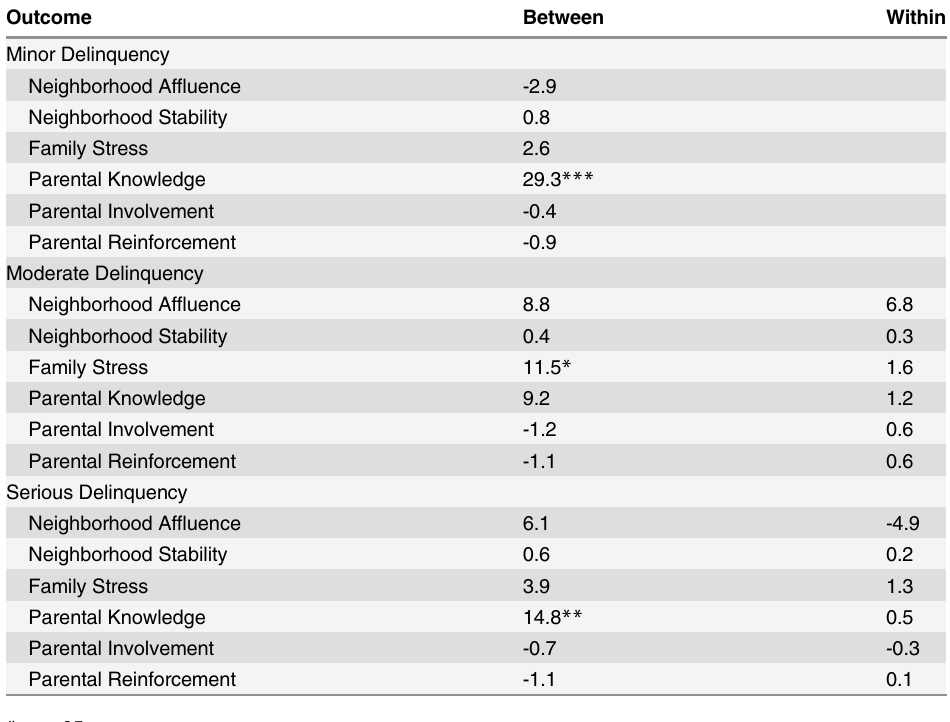
Table 7. Percentage of SES Effect Accounted for by Mediator. Note . Significance tested using Sobel test [50]. Outcome Between Within Minor